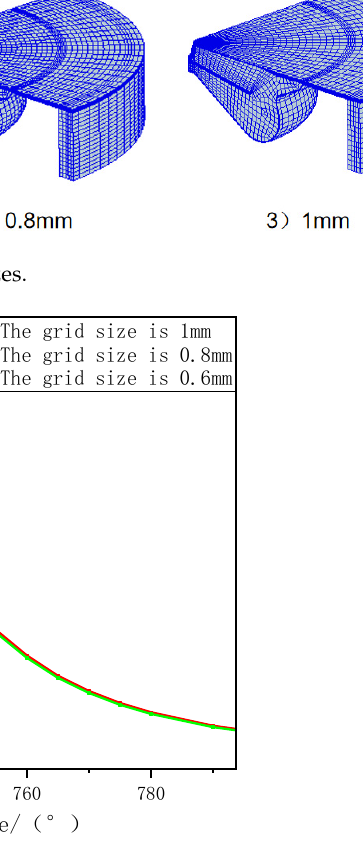
Figure 3. In-cylinder pressure curves of different grid sizes.